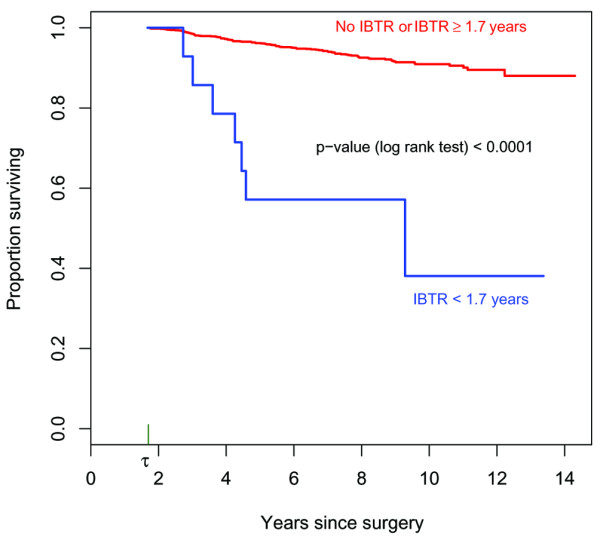
Kaplan–Meier estimate of disease-specific survival by IBTR status at 1.7 years (τ) after surgery. IBTR, ipsilateral breast tumour recurrence.